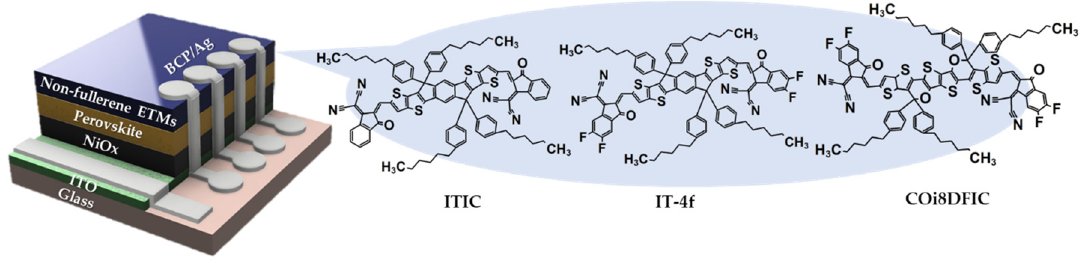
Figure 1. Schematic illustration of the molecular structure of the selected electron transport materials (ETMs) and the device architecture of the inverted, planar, non-fullerene perovskite solar cells (PSC).